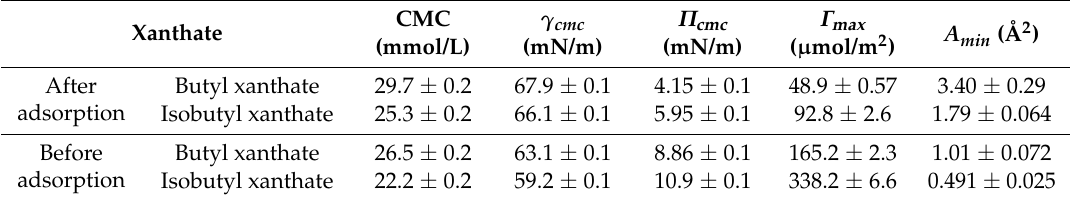
Table 1. Activity parameters of xanthates at 298